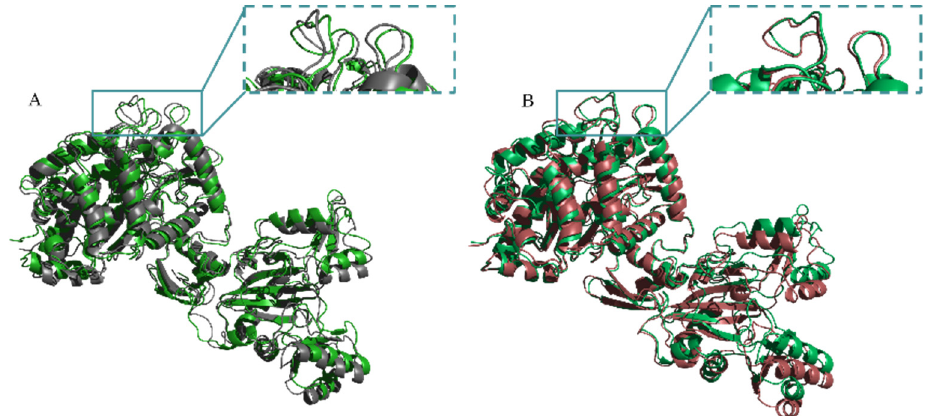
Figure 6. The structure superposition of WT and R270S. ( A ) The structure superposition of WT at 298 K and WT at 313 K; ( B ) The structure superposition of R270S at 298 K and R270S at 313 K.